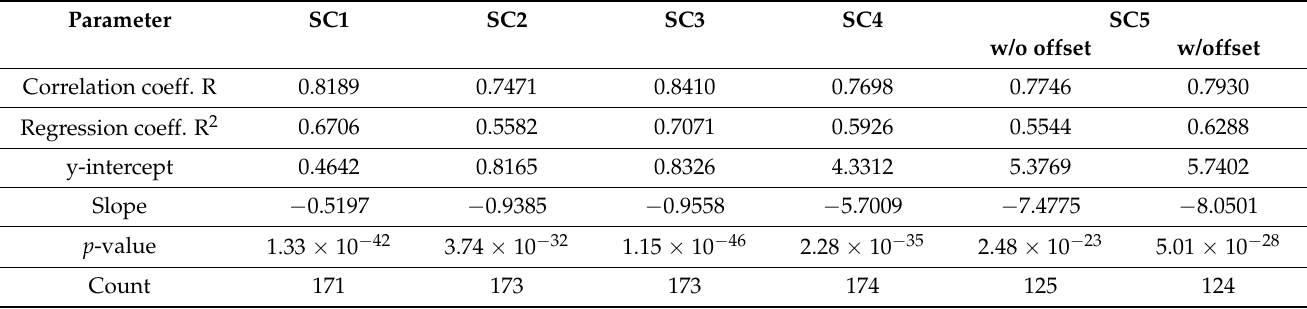
Table 3. The results of the regression analysis between wastewater flow and GWL.